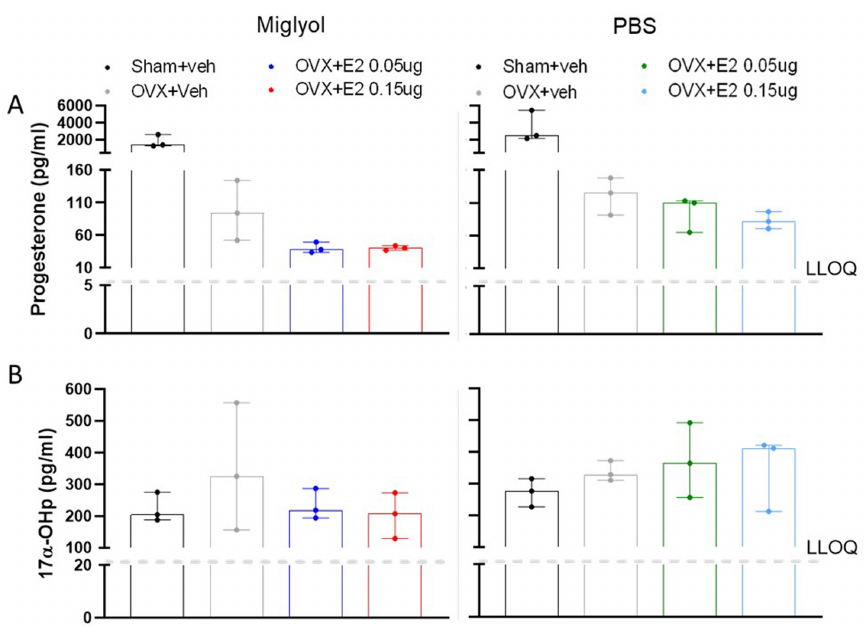
Figure 3. Levels of progesterone and 17α-hydroxyprogesterone in serum after 8 weeks of treatments. The amount of progesterone ( A ) and 17α-hydroxyprogesterone ( B ) was measured in Sham and OVX mice after 8 weeks of s.c. injections every 4 days with vehicle (miglyol or PBS) or 17 β-estradiol (E2; 0.05 µg/mouse or 0.15μg/mouse). Data are expressed as median (range); n=3 for each experimental group. (LLOQ = lower level of